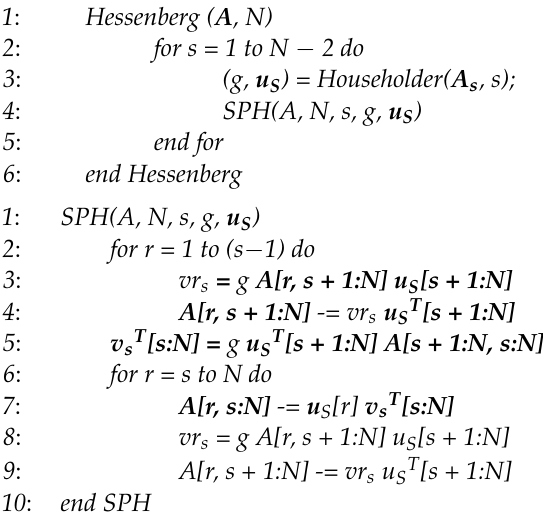
coefficient. SPH —procedure for performing one step of a single-pass Householder trans- formation (Single-Pass Householder). Matrices and vectors are highlighted in bold, and the ranges of index changes are indicated in